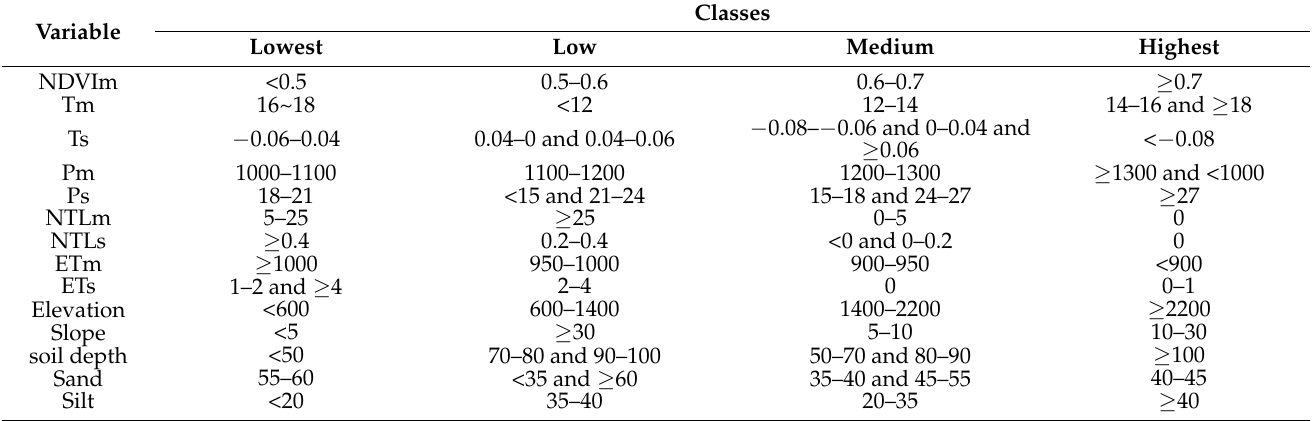
Table 2. Discretization of the BBN model